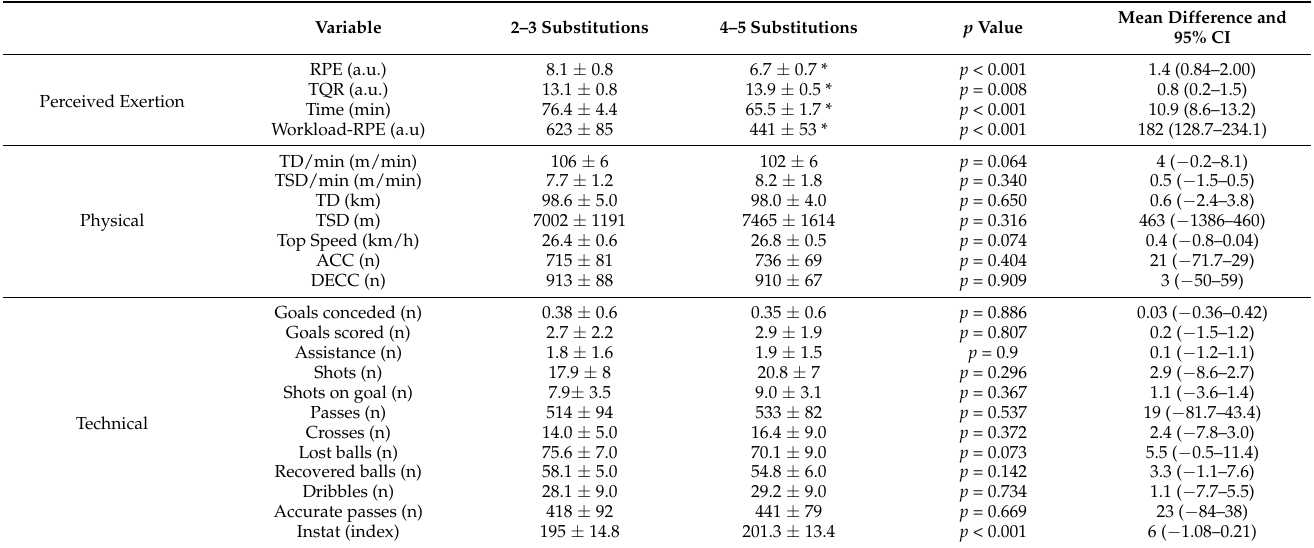
Table 1. Statistics effects between 2–3 and 4–5 substitutions in perceived exertion, physical, and technical variables, mean and